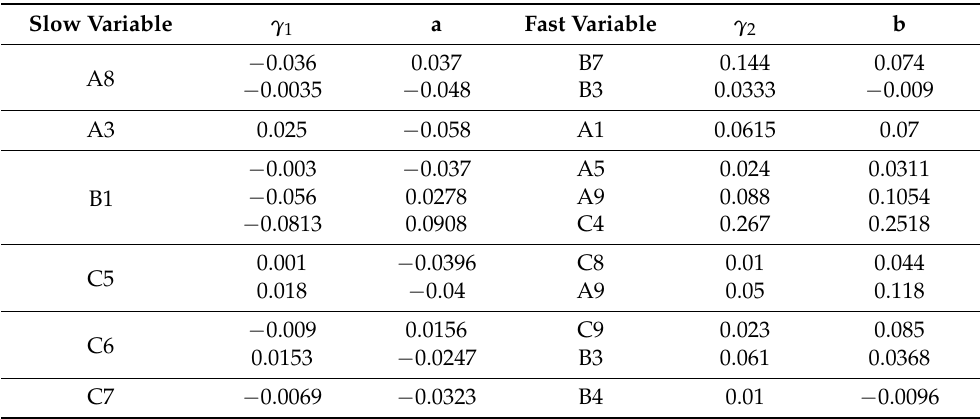
Table 4. Variables and parameter results of Haken